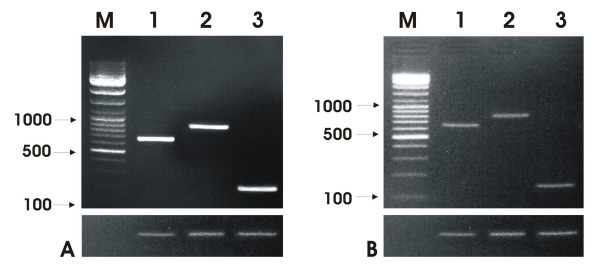
Expression analyses. RT-PCR of samples derived from third order infections' systemic leaves; the plants infected with PVX6His2ACP (A1 and B1), PVX6HisE212ACP (A2) and PVX6HisE222ACP (B2) vectors amplified with PVX FOR and PVX REW specific primers. Lane A3 shows the RT-PCR results for PVX6HisE212ACP using E21 FOR and E21 REW specific primers, whereas in lane B3 for PVX6HisE222ACP samples amplified by E22 FOR and E22 REW specific primers are shown. To evaluate the relative levels of mRNAs, the actin gene was used as an internal control (lower A and B panels). Each experiment was performed in triplicate.